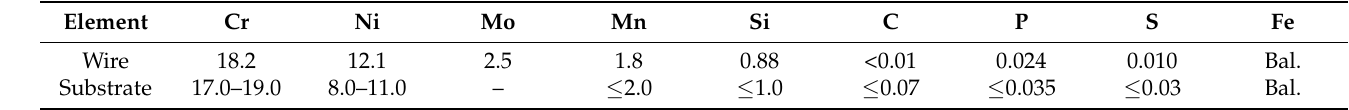
Table 2. Chemical composition of the wire and the substrate material